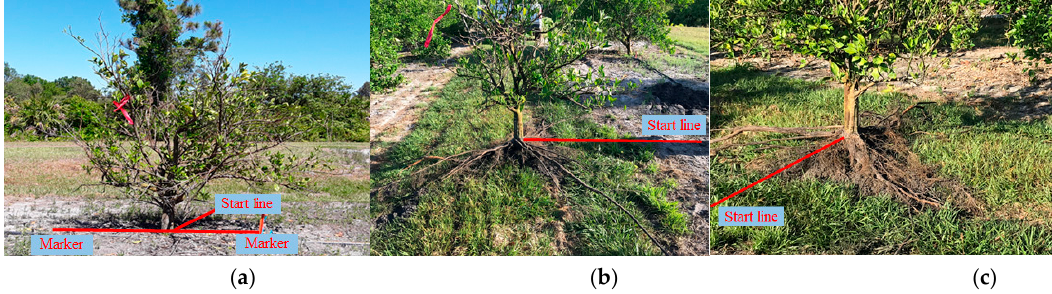
Figure 6. Hamlin / X-639 tree and its root system: ( a ) Front view of tree; ( b ) Front view of tree roots; and, ( c ) Back view of tree roots.